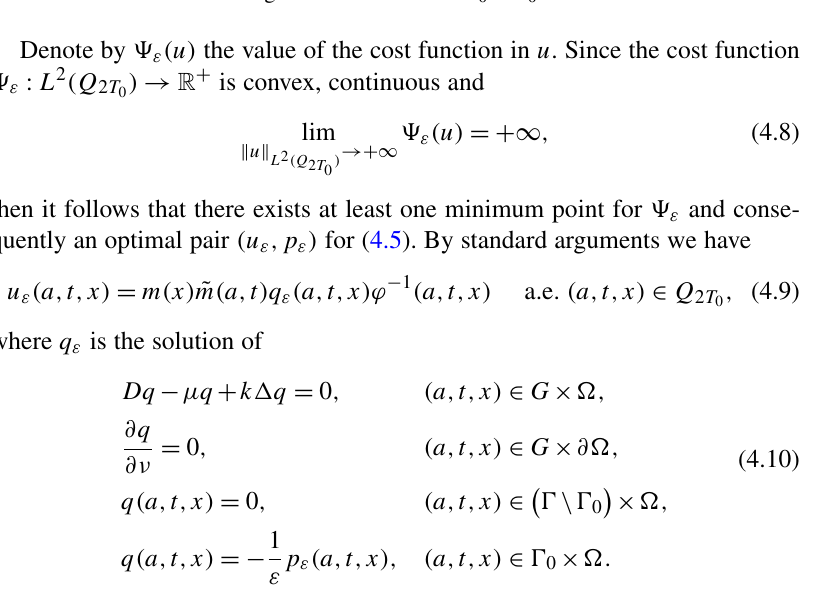
Figure 4.1. Case where T 0 = a 0